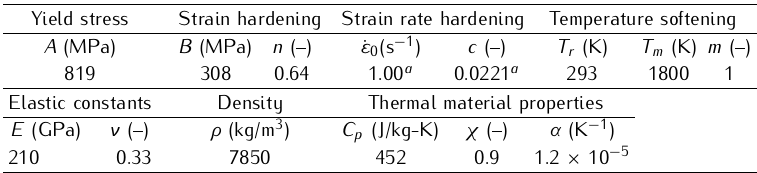
Table 4. Weldox 700E material constants for the modified JC constitutive model [25]. Yield stress